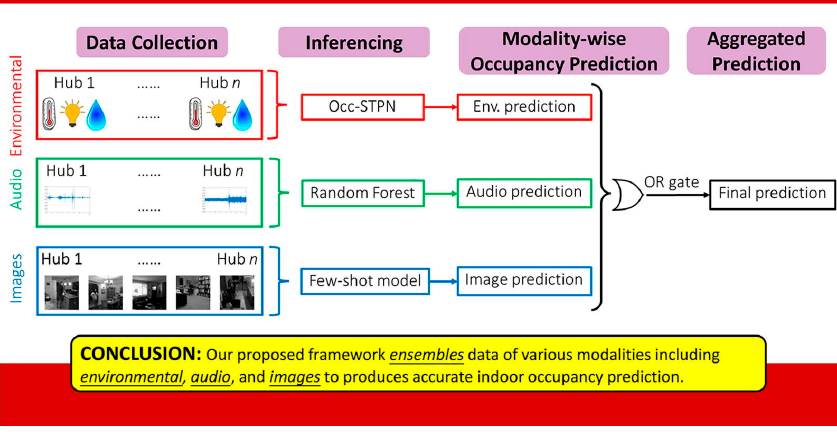
Figure 12. The multimodal sensor fusion framework in Ref. [128].